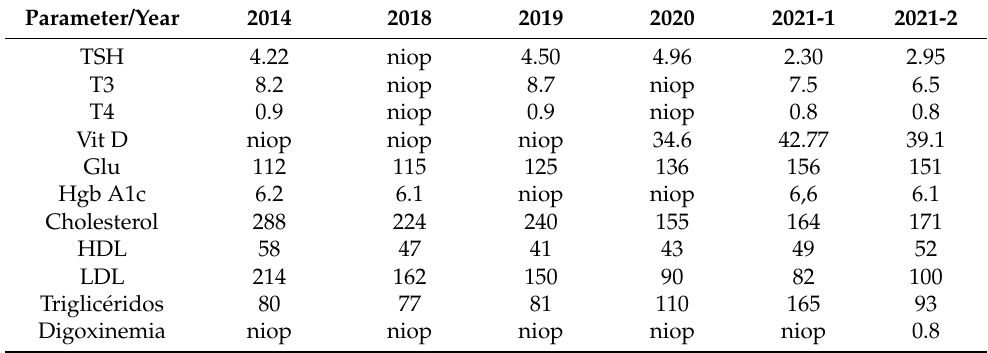
Table 2. Control serum parameters.